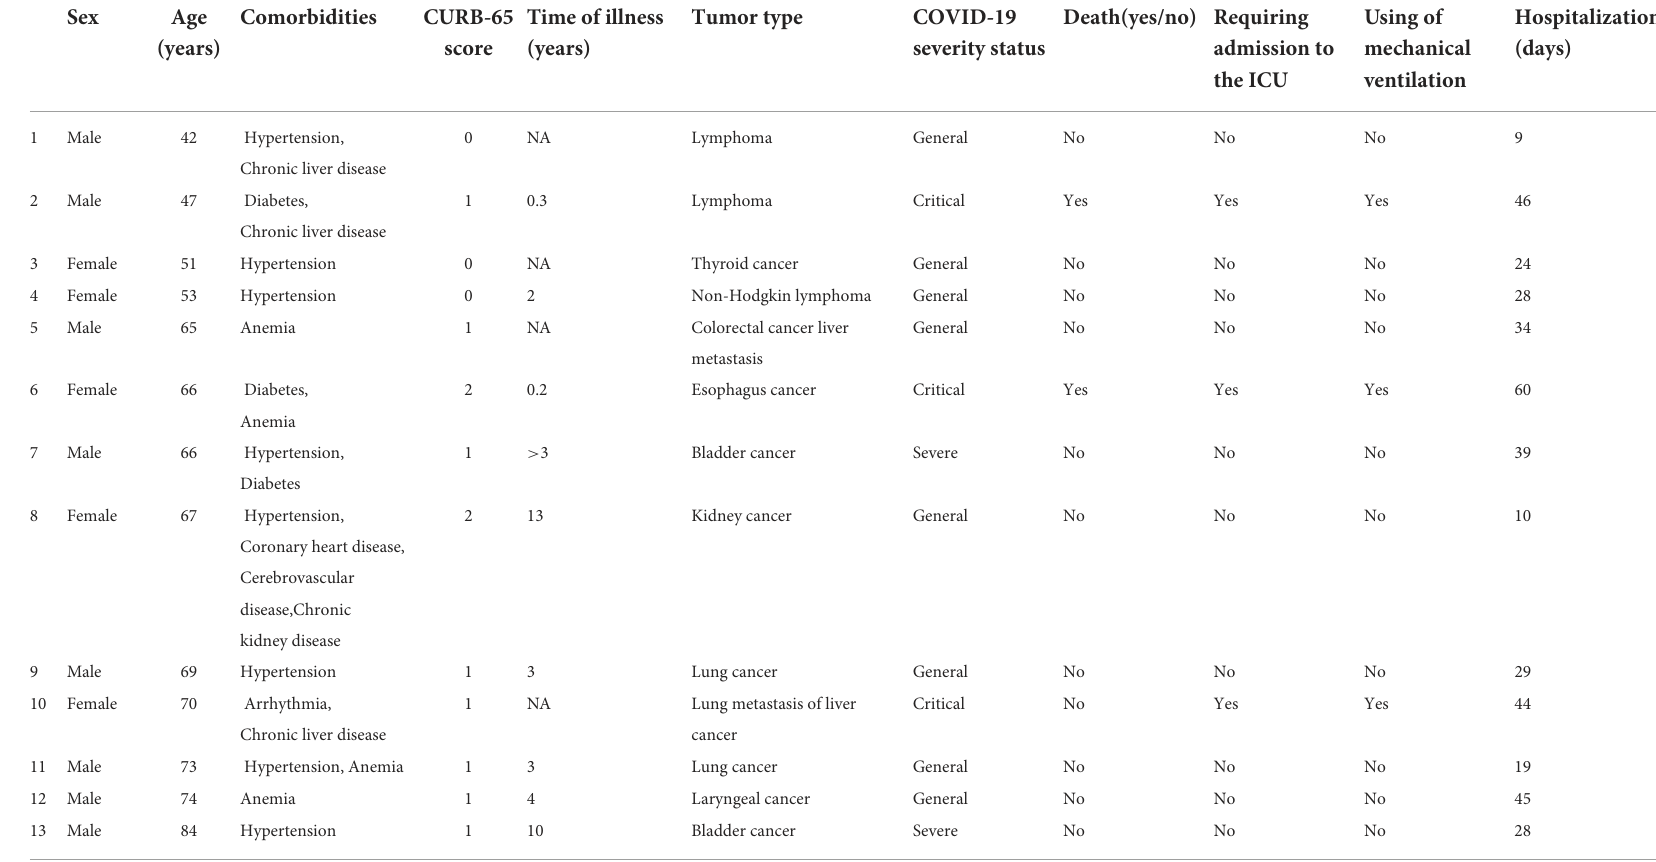
TABLE 1 Clinical characteristics and outcomes of cancer patients infected with